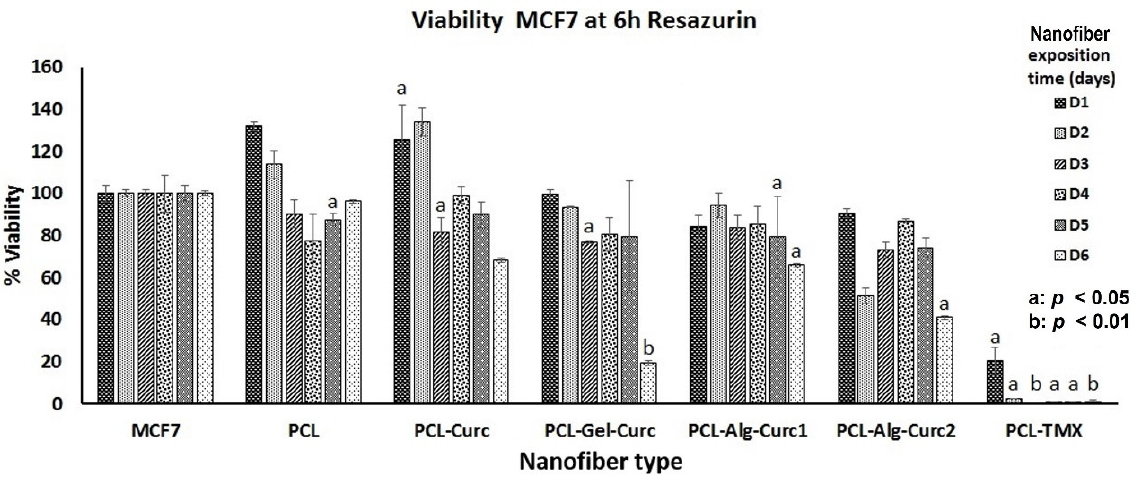
Figure 8. Viability percentage of MCF-7 cells treated with the different nanofibers for six days. The reduction in resazurin to resorufin was measured at 6 h. The student’s t -test was used to establish significance.